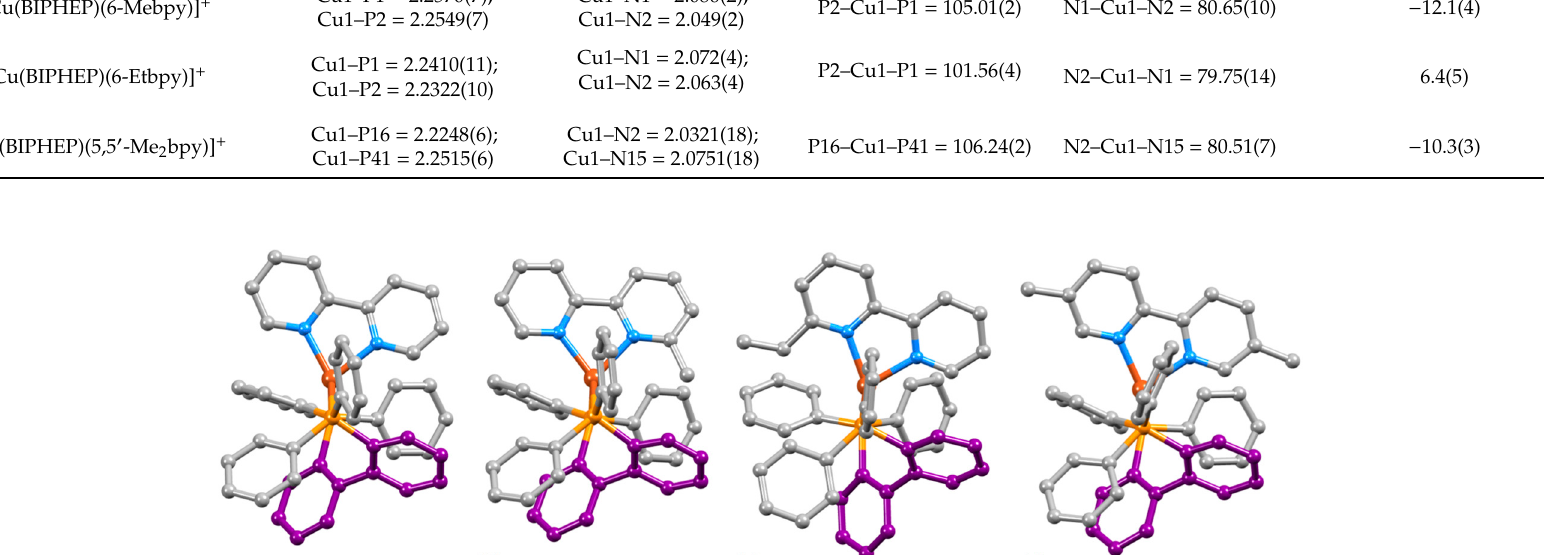
Figure 7. Comparisons of the distorted tetrahedral coordination spheres (viewed along the P...P vector) of copper(I) in (a) [Cu(BIPHEP)(bpy)] ( b ) [Cu(BIPHEP)(6-Mebpy)] + ( τ 4 = 0.85), ( c ) [Cu(BIPHEP)(6-Etbpy)] + ( τ 4 = 0.78), and ( d ) [Cu(BIPHEP)(5,5 (cid:48) -Me 2 bpy)] + ( τ 4 = 0.80). The origin of the chirality is the twisted backbone of BIPHEP (shown in